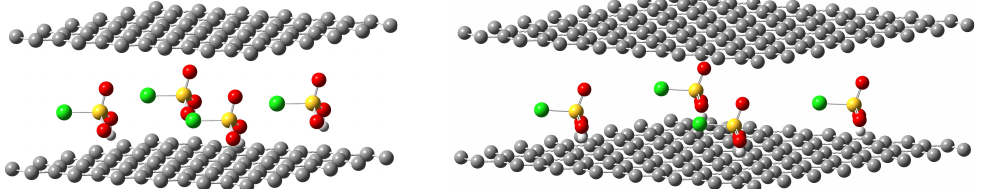
Figure 4. Chlorosulfonic acid in between AA-BLG (2 × 2 × 1 supercells) for two concentrations. Intercalation energy per acid molecule is defined